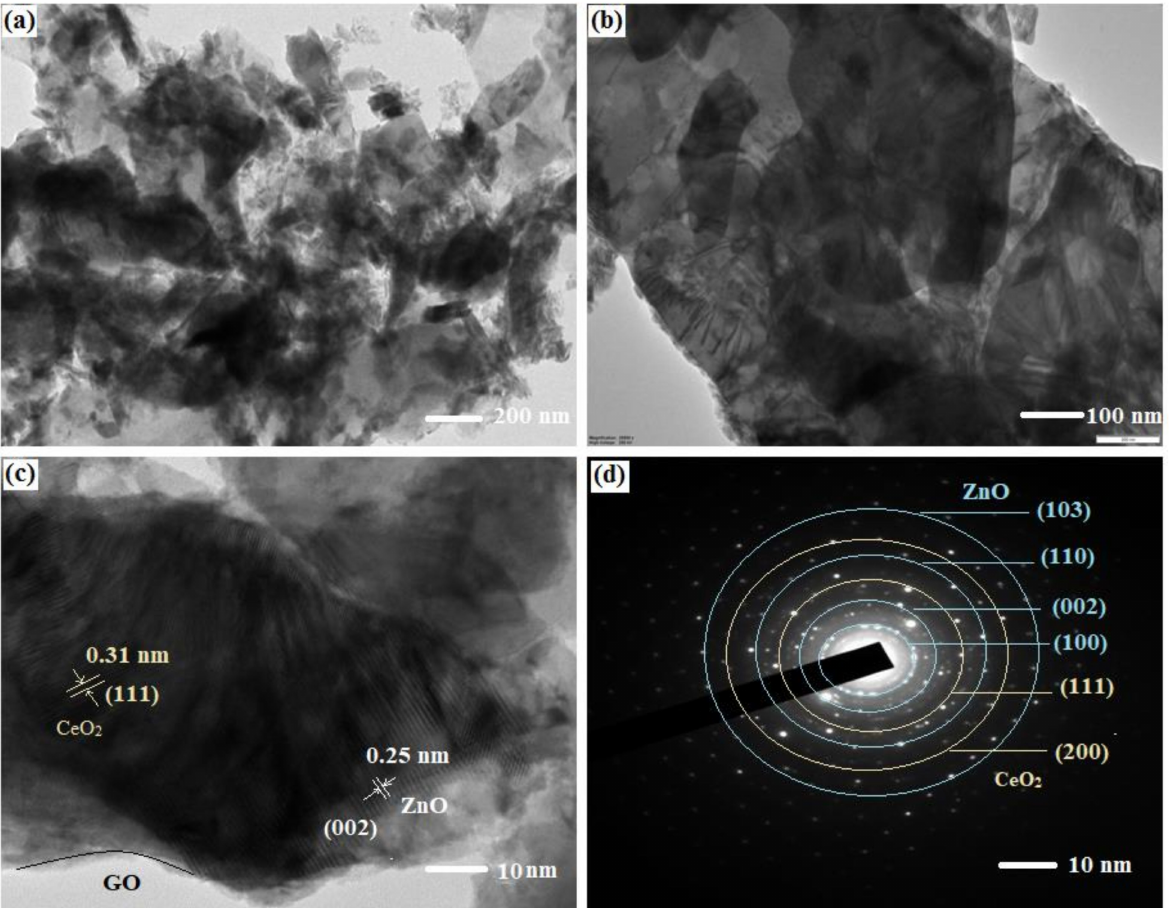
Figure 1. HR-TEM images of ( a – c ) GO-ZnO@CeO 2 nanohybrids and ( d ) SAED